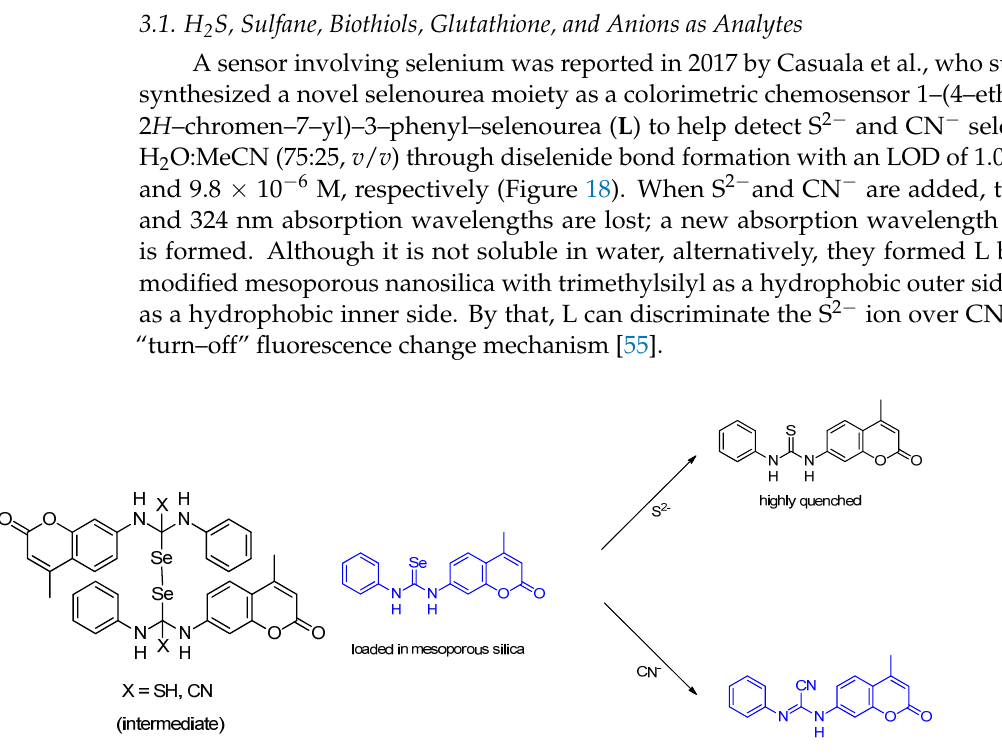
Figure 18. The structure of chemosensor 1–(4–ethyl–2–oxo–2 H –chromen–7–yl)–3–phenyl–selenourea (L) which, as synthesized by Casula et al. demonstrated, the detection of S 2 − and CN − .